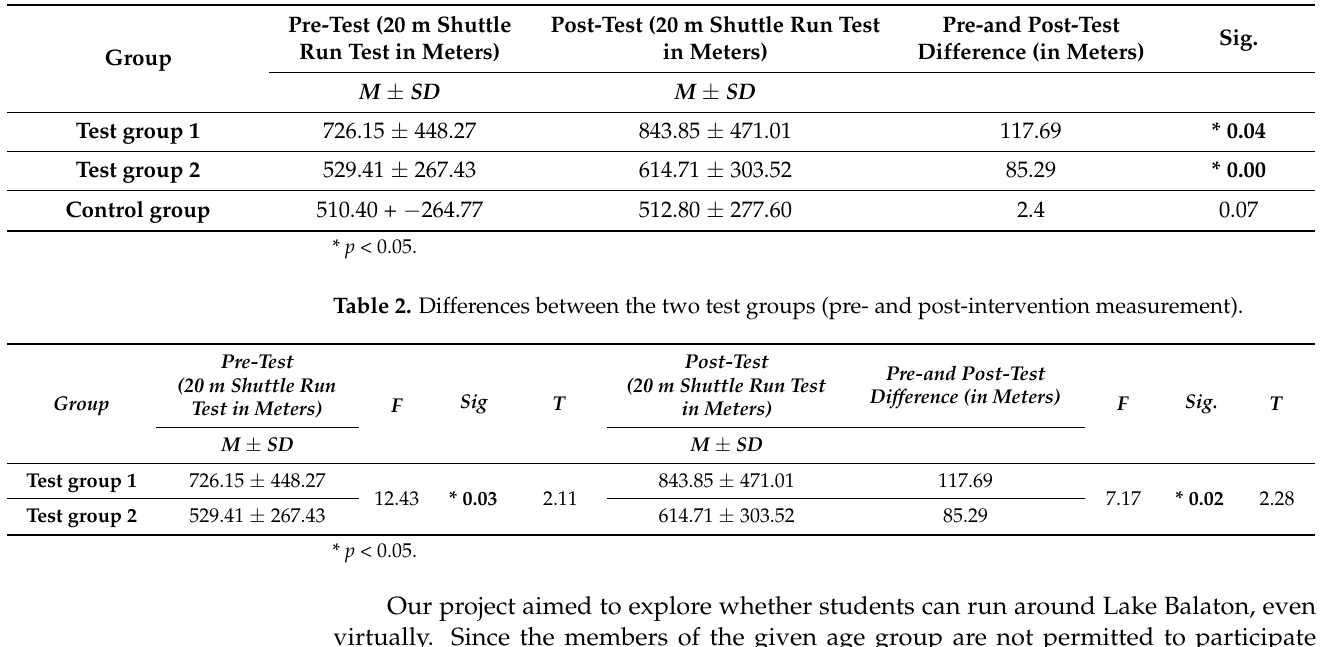
Table 1. A group-based breakdown of student performance prior to and after intervention.